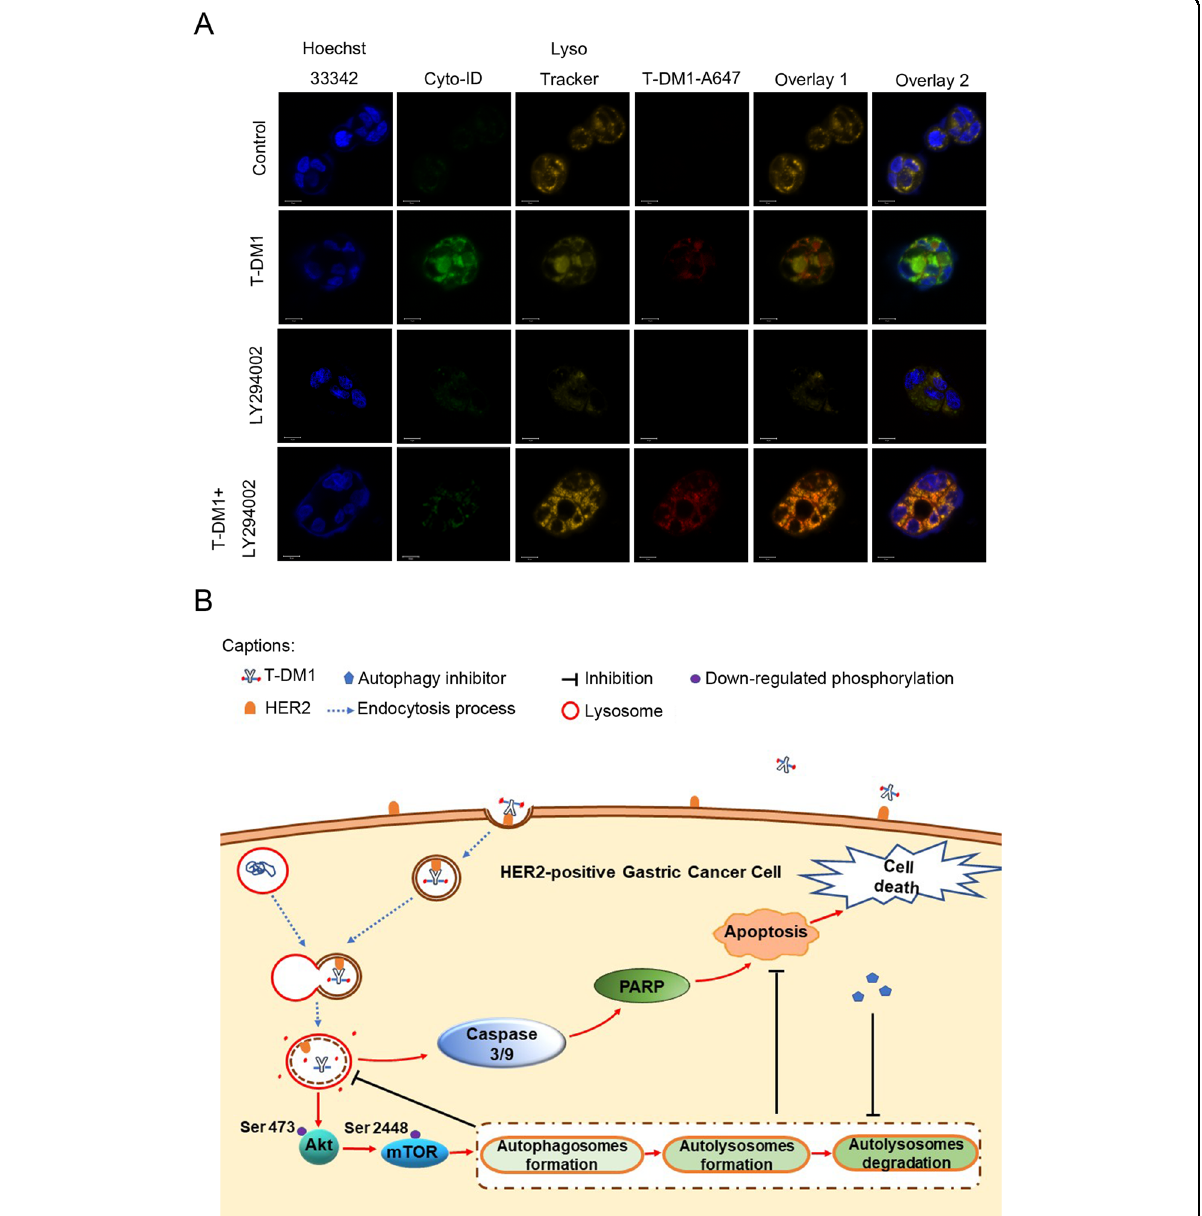
(red fl uorescence) and lysosomes (yellow fl uorescence) in NCI-N87 cells visualized by Cyto-ID staining and LysoTracker staining was determined by confocal microscopy after treatment with fl uorescently labeled T-DM1 in the presence or absence of LY294002 for 24 h. T-DM1 was labeled with the Alexa Fluor ™ 647 Microscale Protein Labeling Kit. B A graphical illustration of how T-DM1 and autophagy activation could cause enhanced effects on HER2-positive GC. First, T-DM1 was internalized into cells by targeting the HER2 receptor, and emtansine was released in lysosomes by degradation of the HER2-T-DM1 complex. Moreover, T-DM1 induced cytoprotective autophagy by inactivating the Akt/mTOR signaling pathway and induced apoptosis with activation of caspases 3/9 and PARP. Furthermore, autophagic inhibition could promote the fusion of T-DM1 with lysosomes, signi fi cantly enhance apoptosis and augment the therapeutic effect of